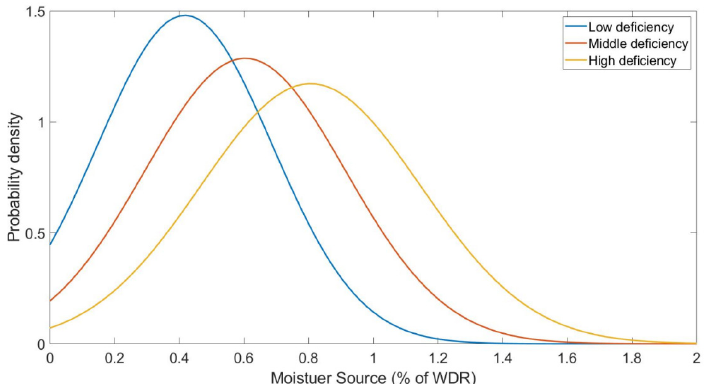
Figure 5. Probability density functions of rain leakage moisture source (% of wind-driven rain).